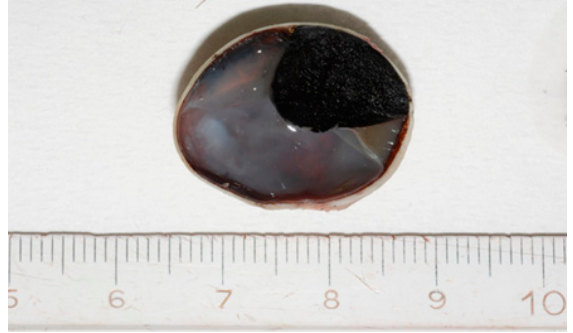
Figure 1. Grossly, Choroidal melanoma (CM) appears on the cut section as a dome-shaped pigmented mass protruding into the posterior segment of the eye.